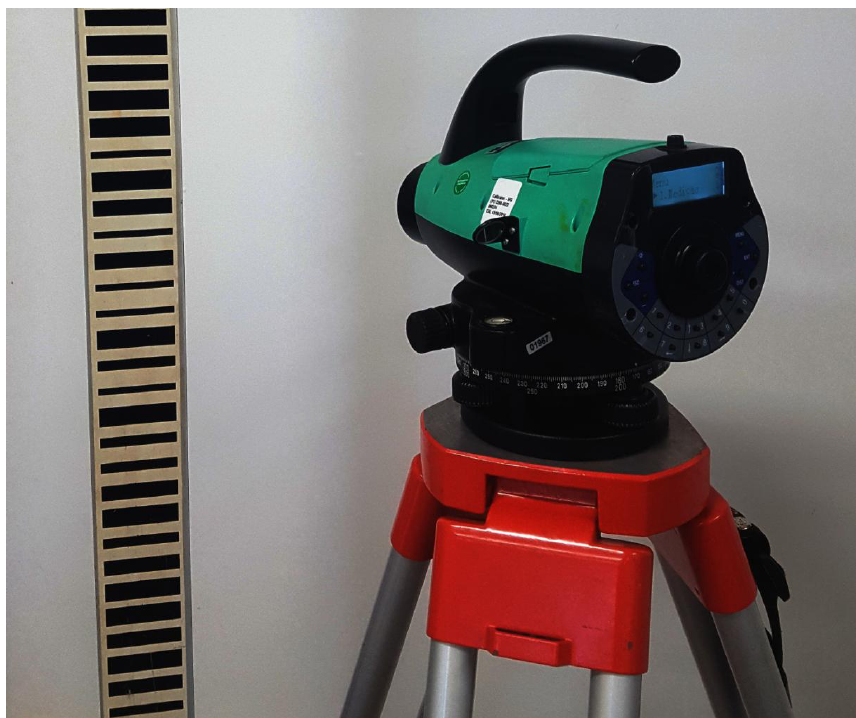
Figure 4. Example of a digital level – barcode staff